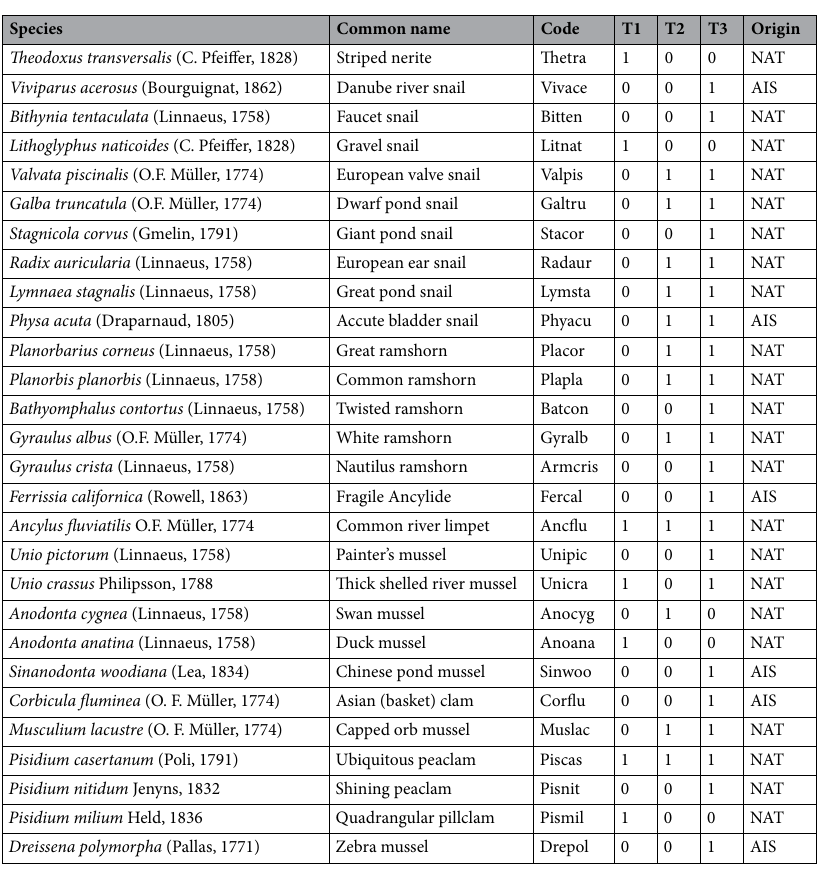
Table 1. List of freshwater mollusk species identified in the study area, related to time and origin. Code—code of species; Period: T1—XIXth century, T2—1995–2000, T3—2020; Origin: NAT—native species; AIS—alien invasive species; Occurrence: 1—presence,